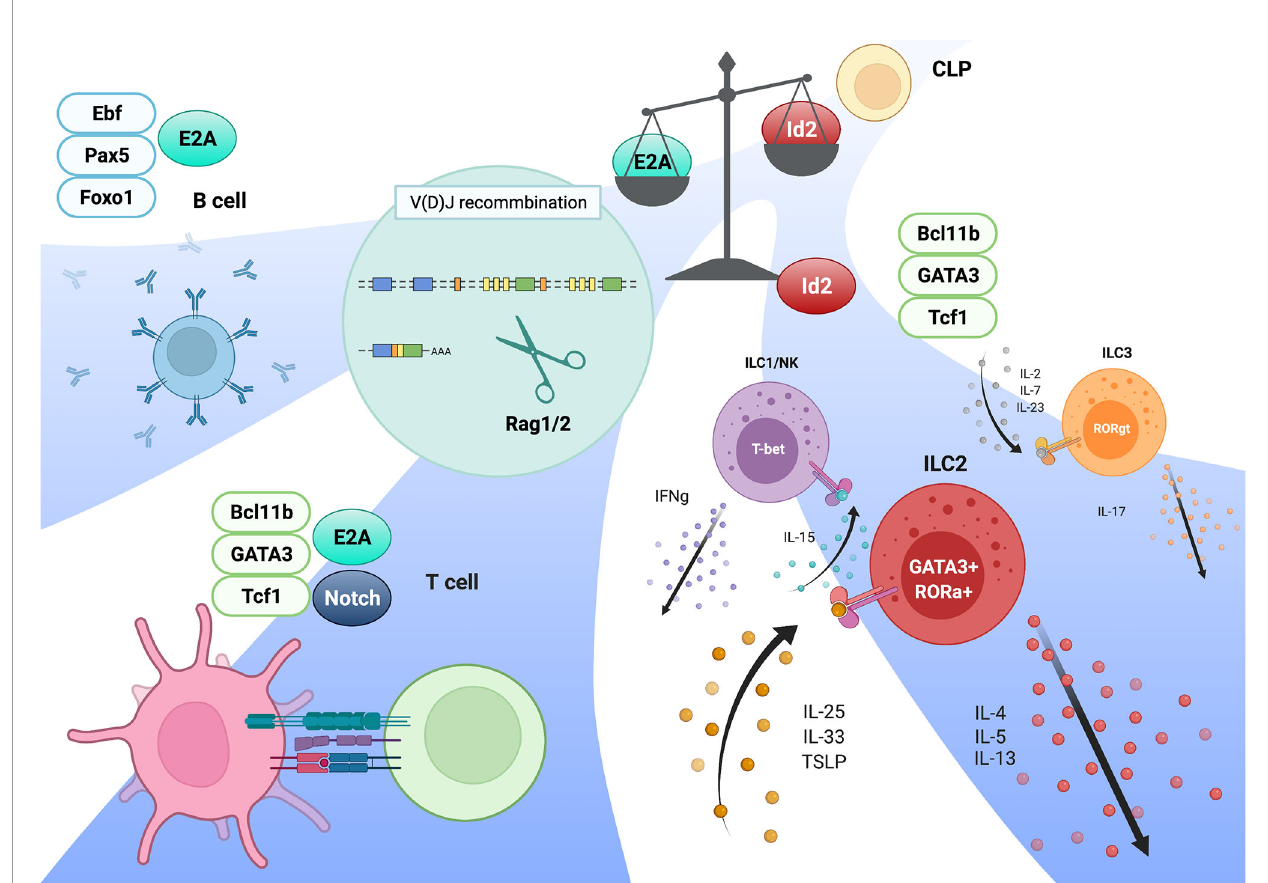
FIGURE 1 | Model of adaptive and innate lymphocytes lineages mediated by the E-Id axis. The magnitude of E protein transcriptional activity determines the lineage commitments of adaptive versus innate lymphocytes. Following this process, an ensemble of TFs speci fi c for each lineages validates lineage-speci fi c gene expression program, along with E proteins in T and B cells. This fi gure was created with